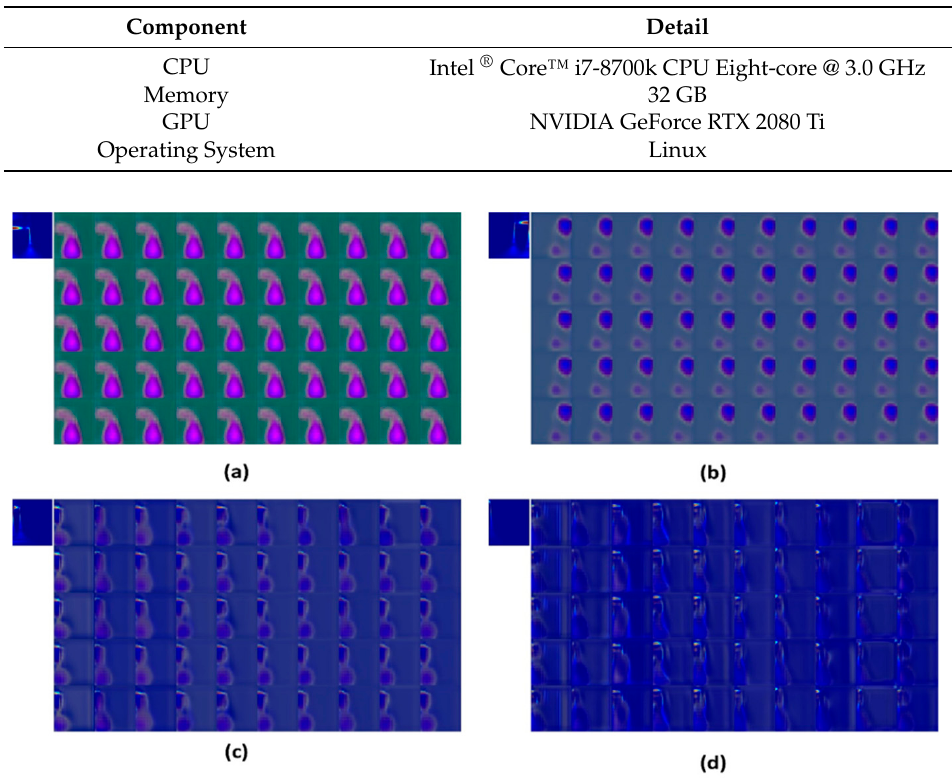
Table 6. PC specifications.